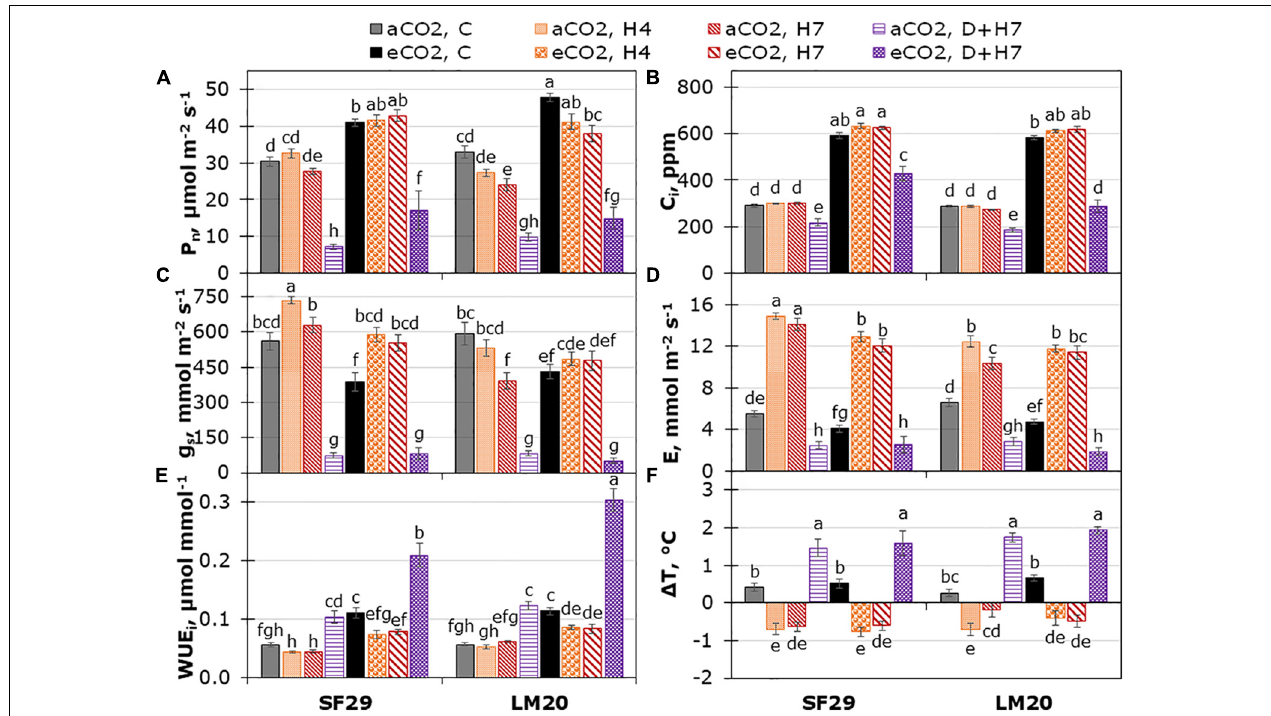
FIGURE 1 | Leaf gas exchange measured at PPFD of 2,000 µ mol m - 2 s - 1 . (A) Net photosynthetic rate (P n ), (B) intercellular CO 2 (C i ), (C) stomatal conductance (g s ), (D) transpiration rate (E), (E) intrinsic water use efficiency (WUE i ), and (F) difference between leaf and air cuvette temperature ( (cid:49) T) in heat-sensitive (SF29) and heat-tolerant (LM20) genotypes grown under control conditions (C), heat stress at Day 4 (H4), at Day 7 (H7), and combined heat stress and drought at Day 7 (D + H7) at ambient CO 2 (aCO 2 ) or elevated CO 2 (eCO 2 ). The data represent mean values ± standard error (S.E.) ( n = 6–8). Different small letters indicate significant differences within variants according to Duncan’s test after ANOVA ( p <